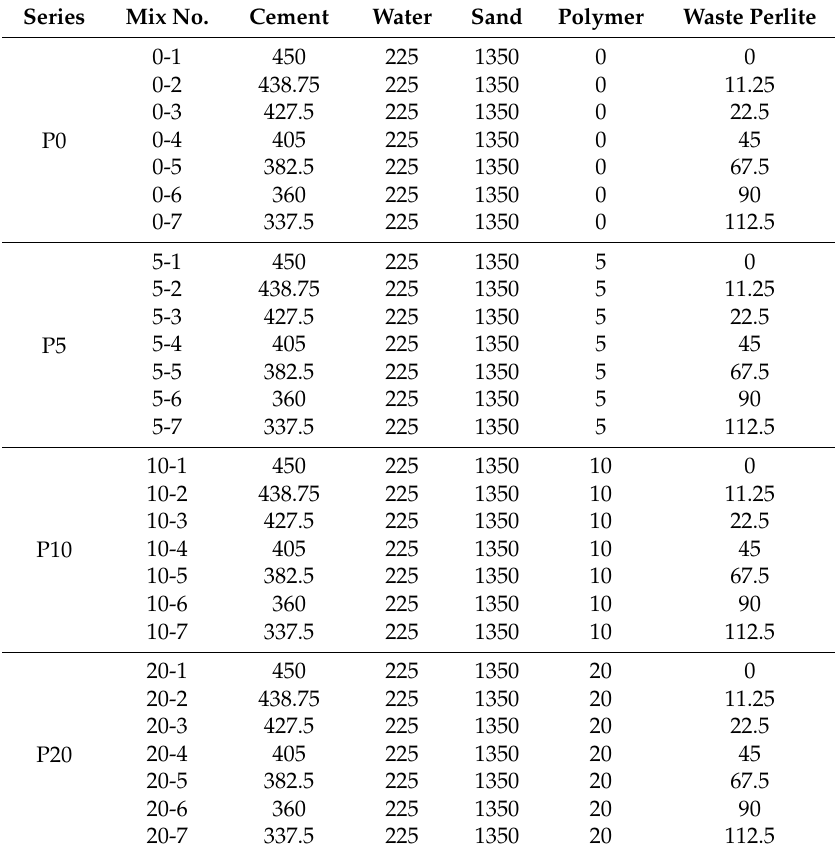
Table 1. Mixture compositions (in g).